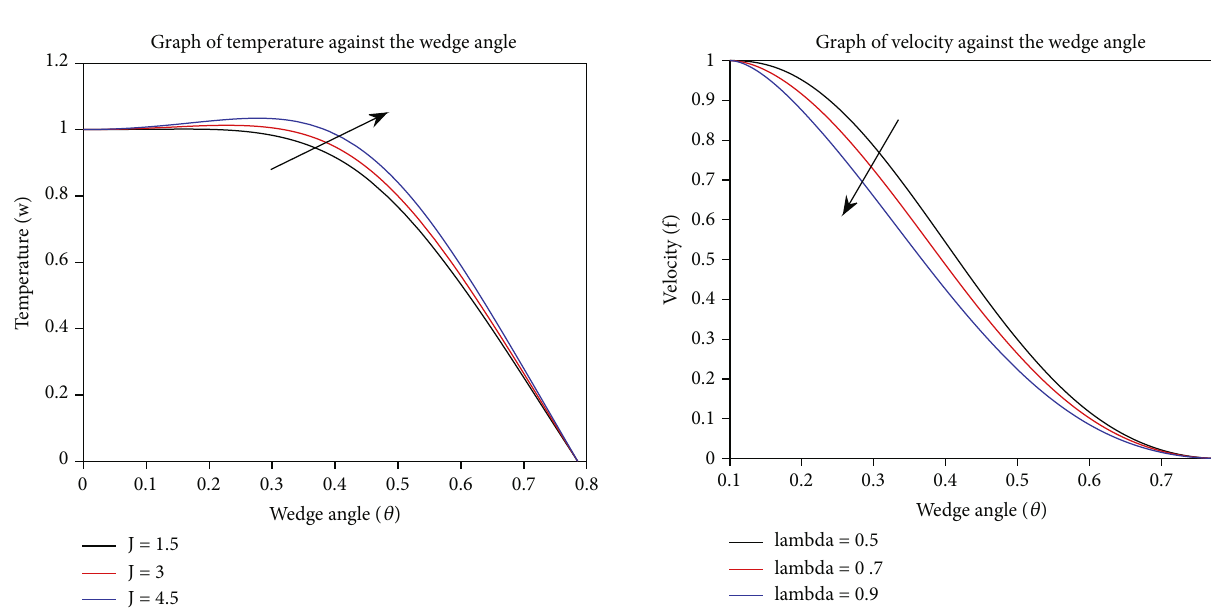
Figure 12: E ff ect of varying the Joule heating parameter on temperature.